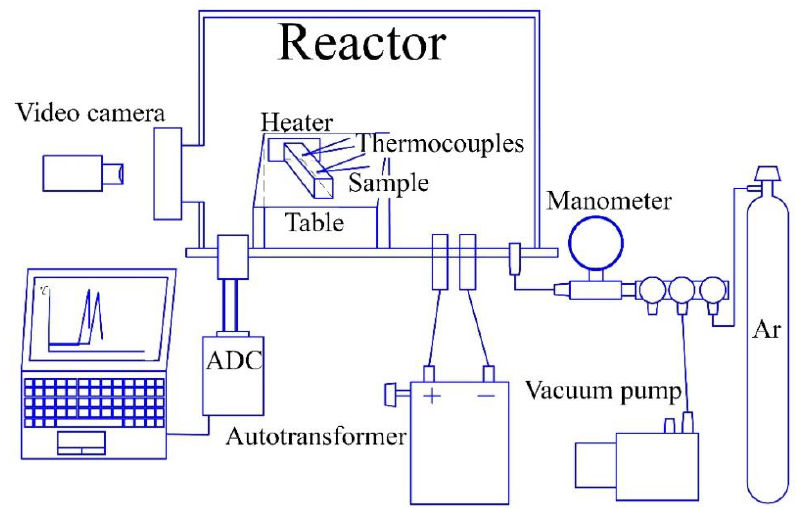
Figure 4. Experimental arrangement for investigating the combustion of reactive materials.